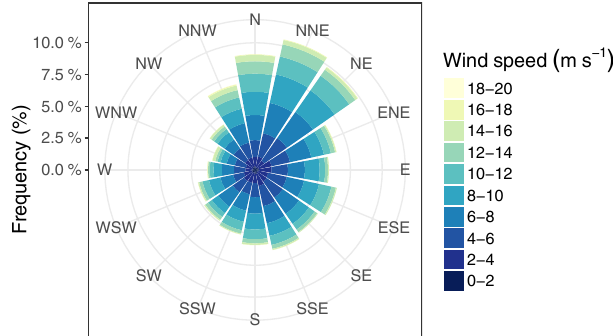
Figure 6. A wind rose, showing the frequency (%) and wind speed (ms − 1 ) for different wind directions at 4m height (22.5 ◦